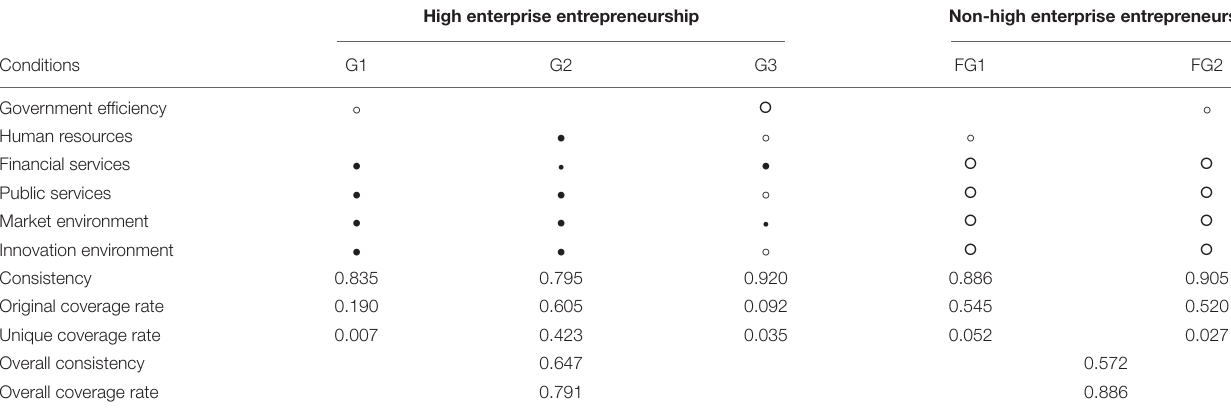
TABLE 7 | Configuration to realize high and non-high single champion enterprise